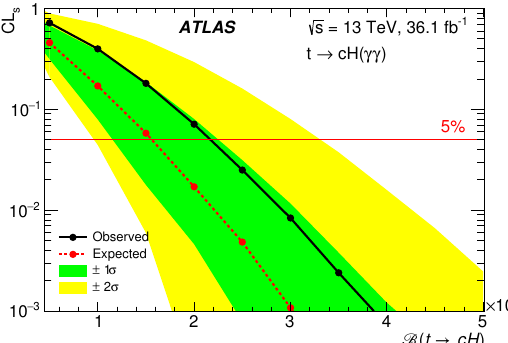
Figure 7. Evolution of the signal con(cid:12)dence level, CL s , as a function of the t ! cH branching ratio B for the observation (full line) and the expectation in the absence of signal (dashed